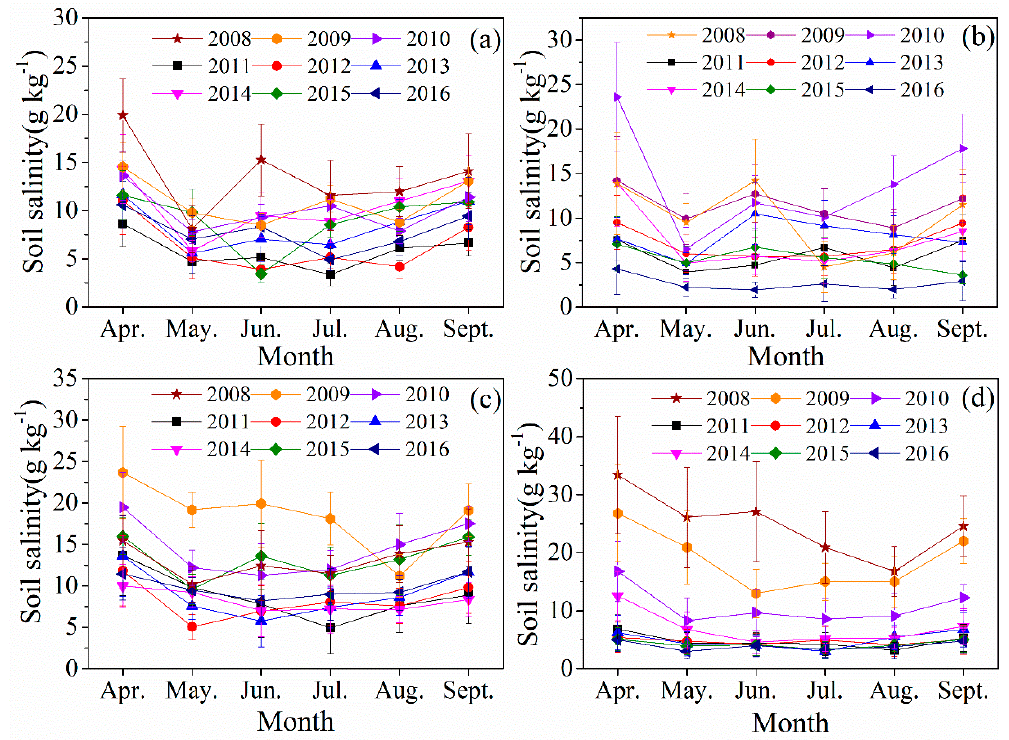
Figure 4. Changes of soil salinity in the 0–60 cm soil layer during the growth period in ( a ) F121, ( b ) F135, ( c ) F144, and ( d ) F145.